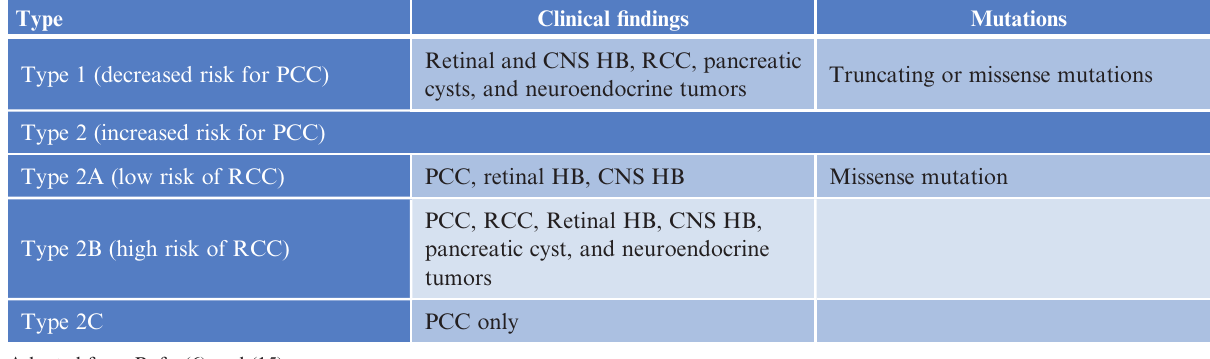
Table 1. Classi fi cation of Von Hippel-Lindau Syndrome Type Clinical fi